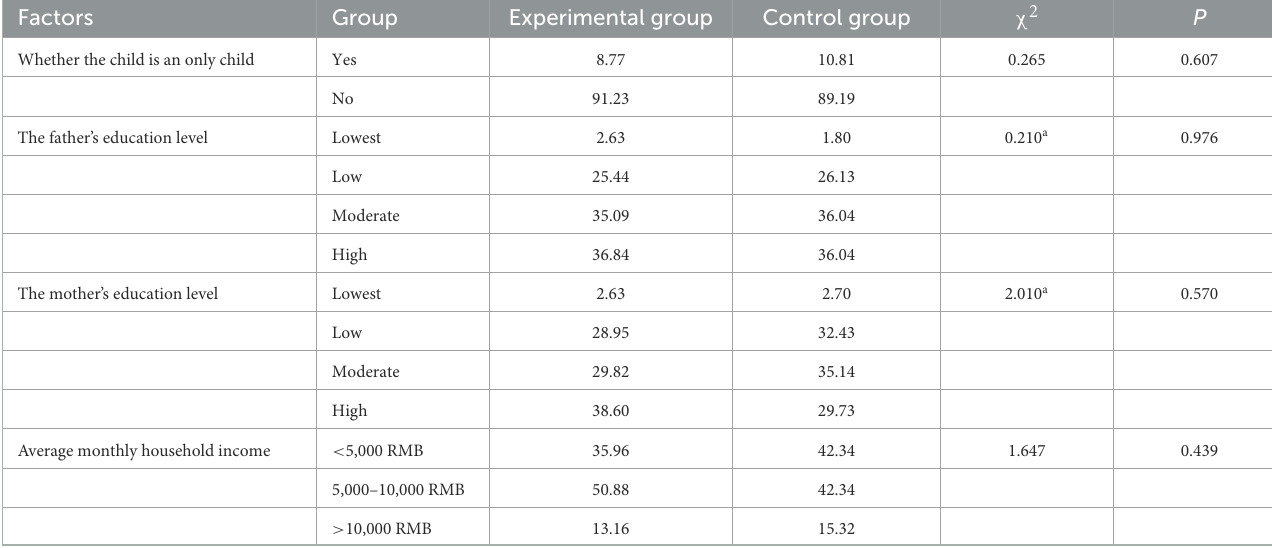
TABLE 1 Baseline information of the two groups